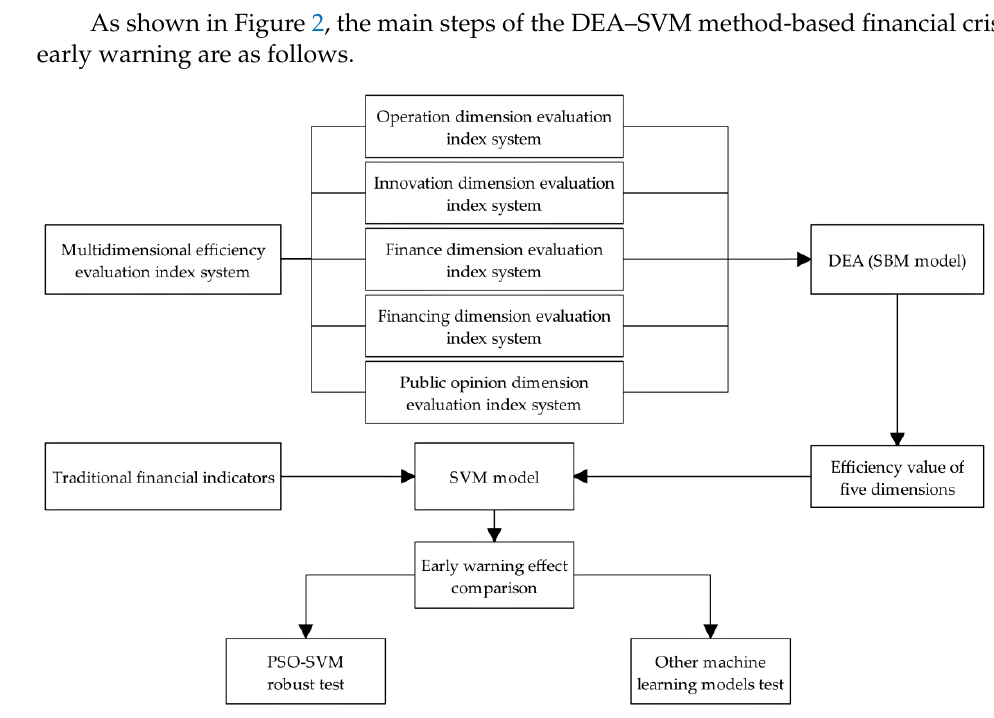
Figure 2. Schematic diagram of the process of the DEA – SVM financial crisis warning method.